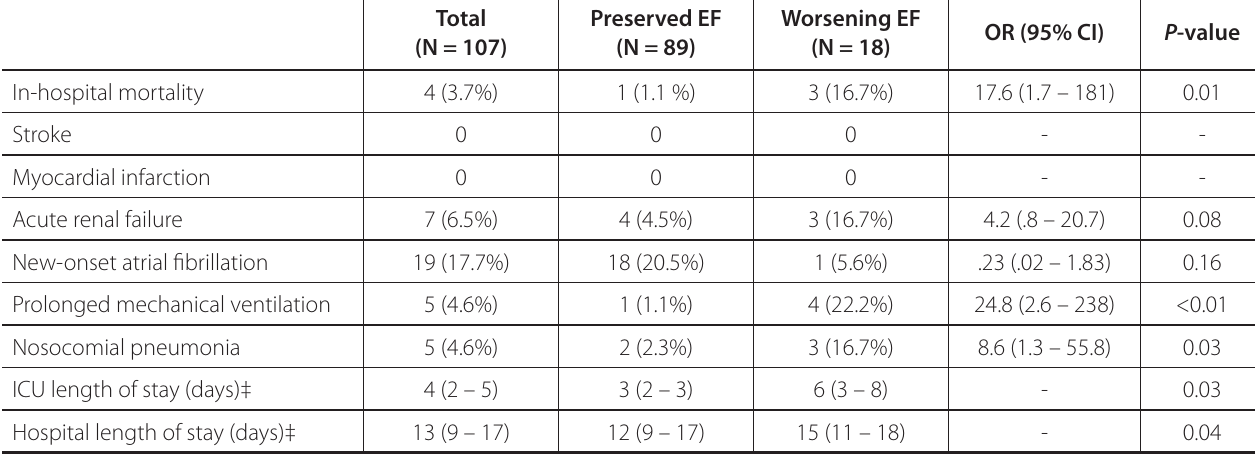
Table 4 . In-hospital surgical outcomes of patients submitted to mitral valve replacement according to study